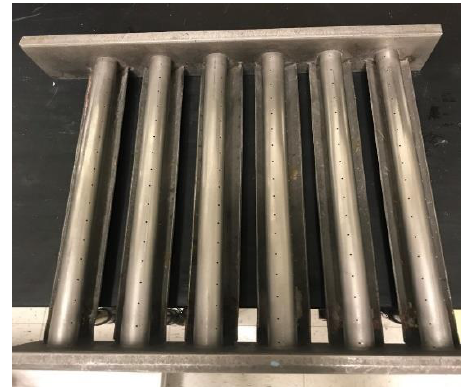
Figure 2. Membrane housing with six slots for 1 foot, ½ inch diameter tubular membranes.